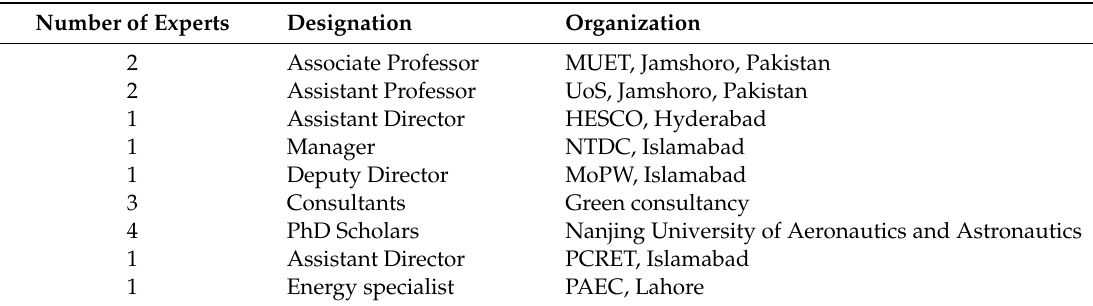
Table 3. The demographic information of